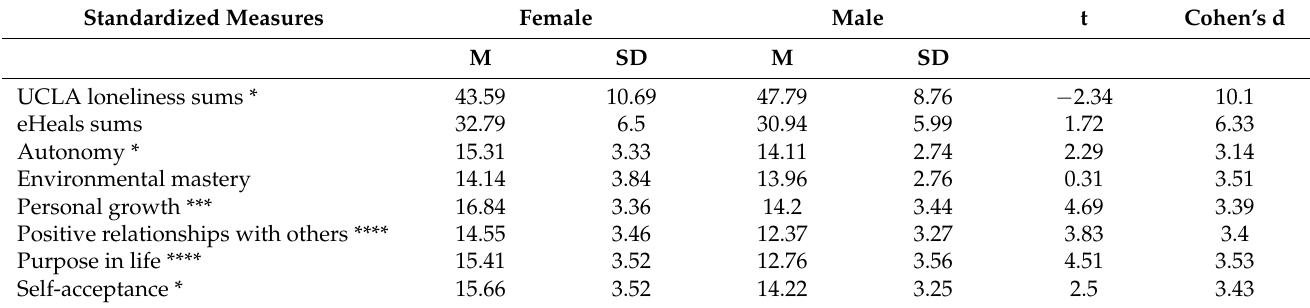
Table 4. Results of t -tests comparing males and females on standardized measures of loneliness (UCLA) eHealth literacy (eHeals) and wellbeing (Psychological Wellbeing).